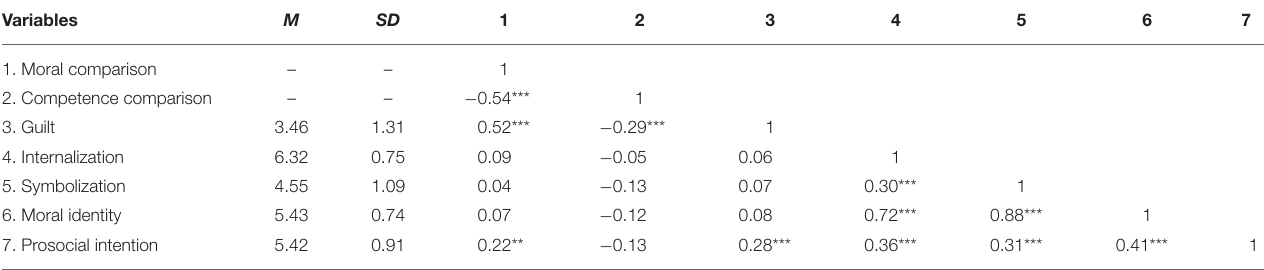
TABLE 1 | Descriptive statistics and correlations between key variables ( N = 162). Variables